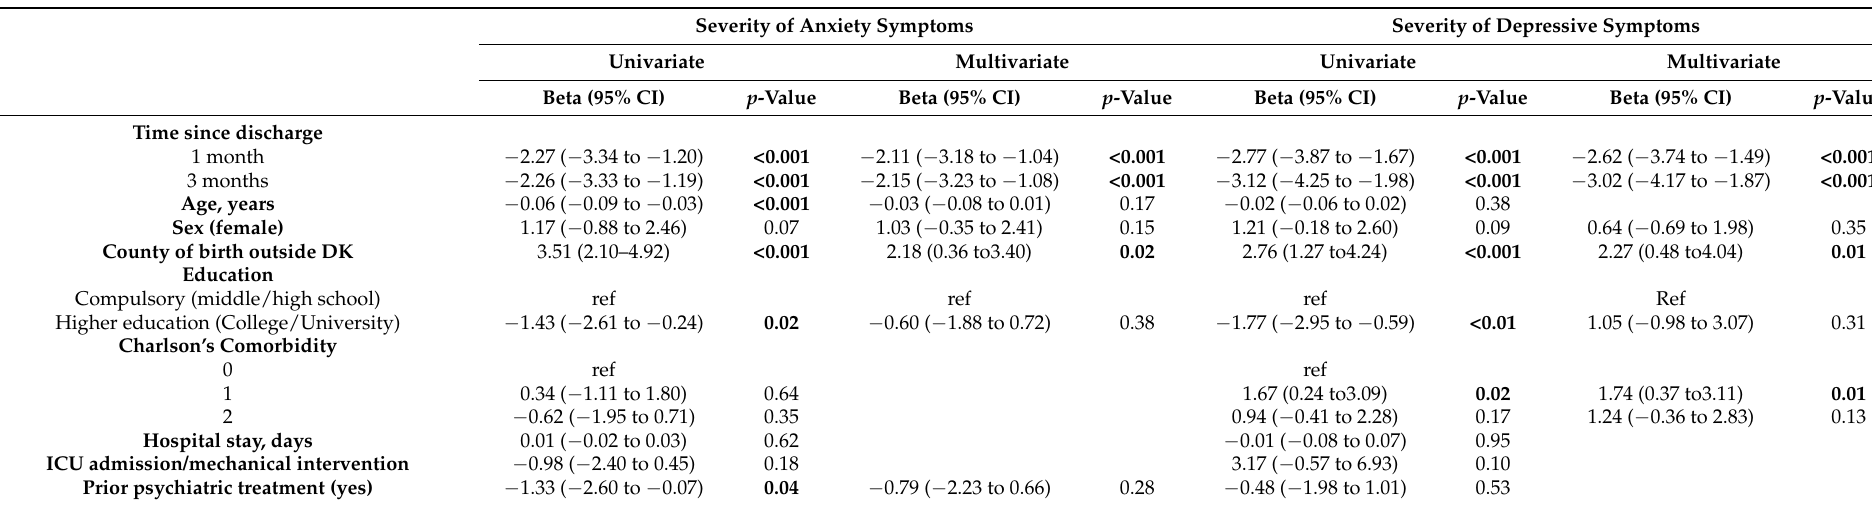
Table 3. Potential factors associated with the severity of symptoms of anxiety and depression among 95 admitted COVID-19 patients during May 2020–May